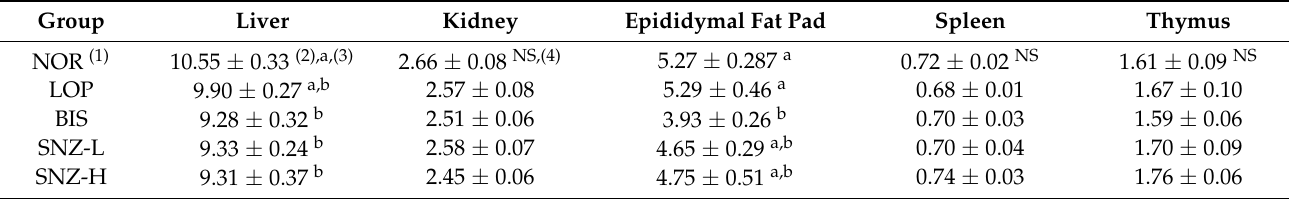
Table 3. Weights of organs of experimental groups